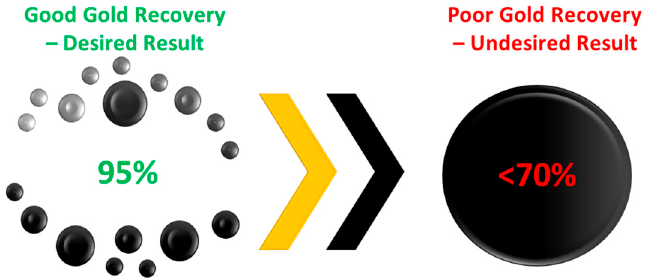
Figure 2. Specific gold extraction technological challenge for current work. Gold recovery reduced from 95% to <70%, leading to loss of about AUD$ 5.7 million per annum.